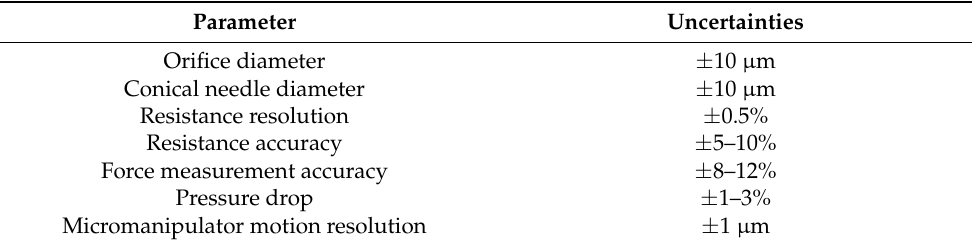
Table 1. Experimental uncertainties.